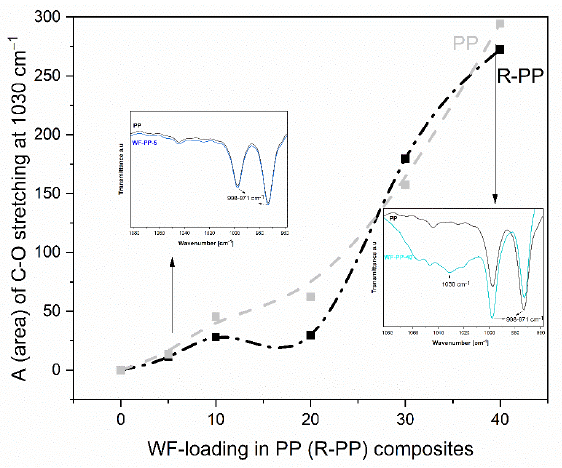
Figure 7. The fraction area (A) of C-O stretching groups at 1030 cm − 1 in WF-PP and WF-R-PP composites as a function of loading. WF. Comparison of the two ATR-FTIR spectra of WF-PP and WF-R-PP composite samples at the surface layer indicates the same behavior of PP -orientation in WF-PP and WF-R-PP